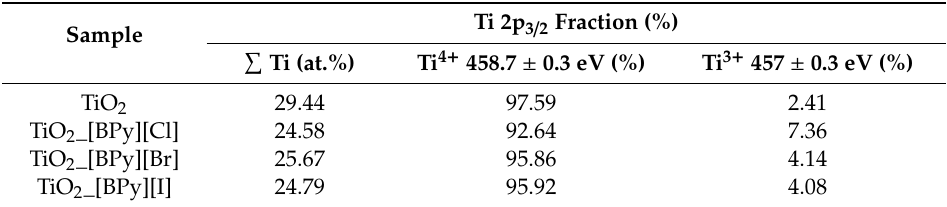
Table 1. Elemental composition (in at. %) and chemical characters of titanium states in the surface